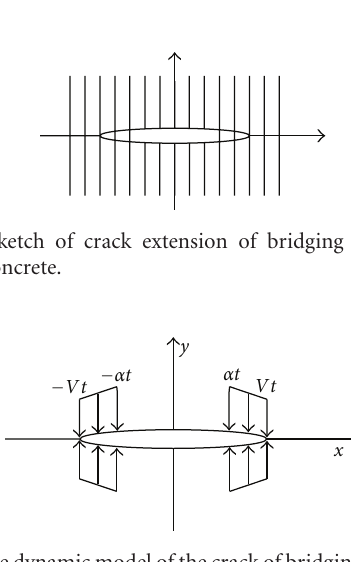
Figure 3: The dynamic model of the crack of bridging fibers in fiber reinforced